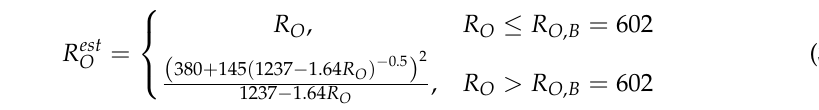
Figure 7. Measured load resistance versus load power [27].